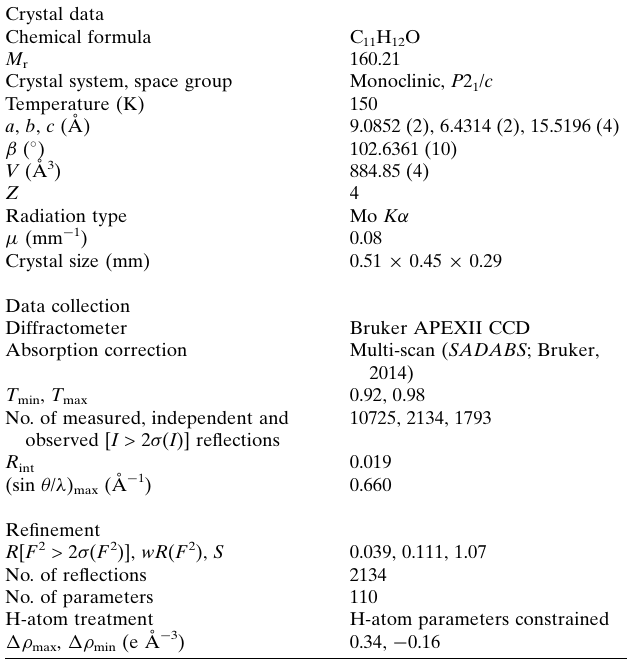
Table 1 Hydrogen-bond geometry (A˚ , (cid:4) ).